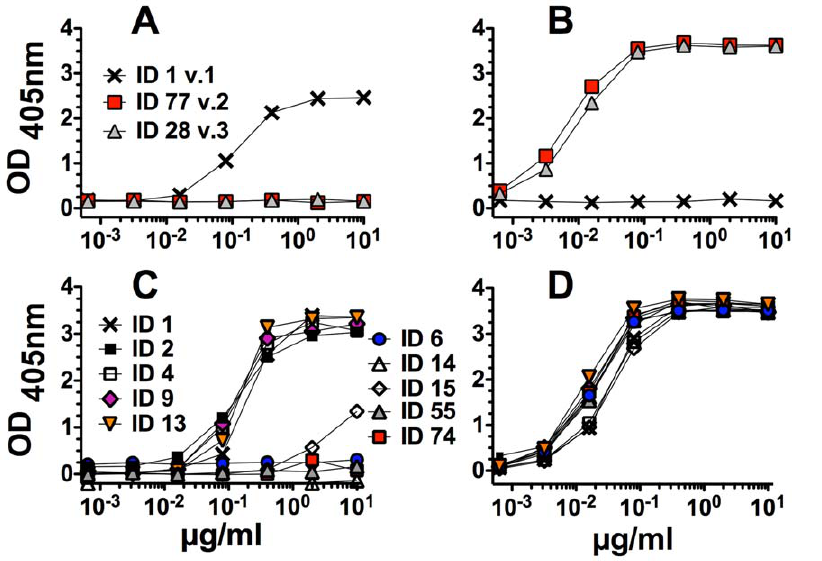
Figure 1. Binding of anti-fHbp mAb JAR 1 to recombinant fHbp as measured by ELISA. Panel A. Binding of JAR 1 to fHbp ID 1 (variant group 1); ID 77 (variant group 2); or ID 28 (variant group 3). Panel B. Binding of a control anti-fHbp, JAR 13, which is specific for fHbp in variant groups 2 and 3 [32]. Sequence variants tested and respective symbols are those shown in Panel A. Panel C. Binding of JAR 1 to variants of fHbp in variant group 1. ID 6, 14, 15, 55 and 74 are negative. ID 1, 2, 4, 9 and 13 are positive. Panel D. Binding of a positive control anti-fHbp mAb, JAR 65, to recombinant fHbp variants shown in Panel C. Wells of the microtiter plates were coated with 2 m g/ml of each recombinant protein. doi:10.1371/journal.pone.0034272.g001 PLoS ONE |